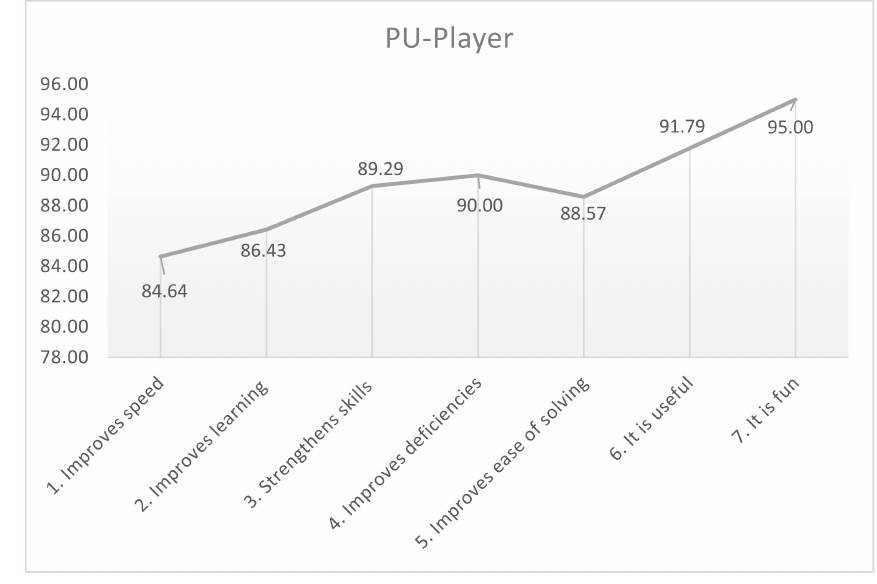
Figure 24. Player Role Answers—Averages per PU